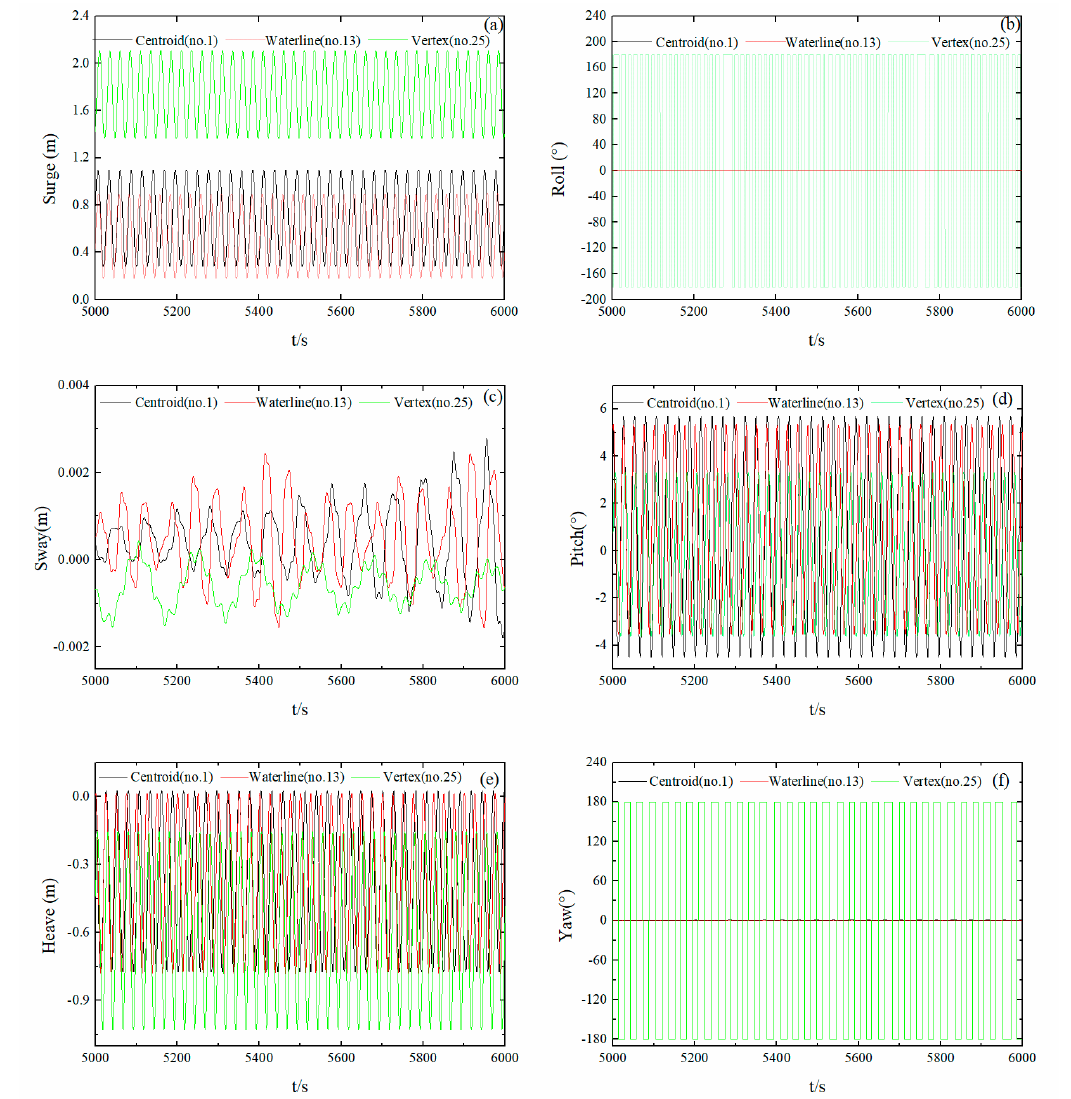
Figure 11. 6DoF motion curves of floats with different mooring points. (Sub-figures: ( a ) surge motion curves; ( b ) roll motion curves; ( c ) sway motion curves; ( d ) pitch motion curves; ( e ) heave motion curves; ( f ) yaw motion curves.)